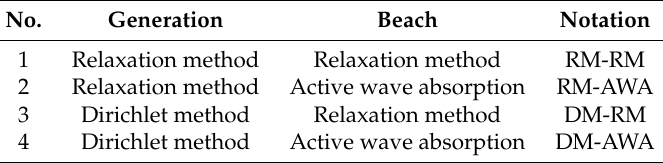
Table 2. Different combinations of wave generation and absorption methods used in the NWT.